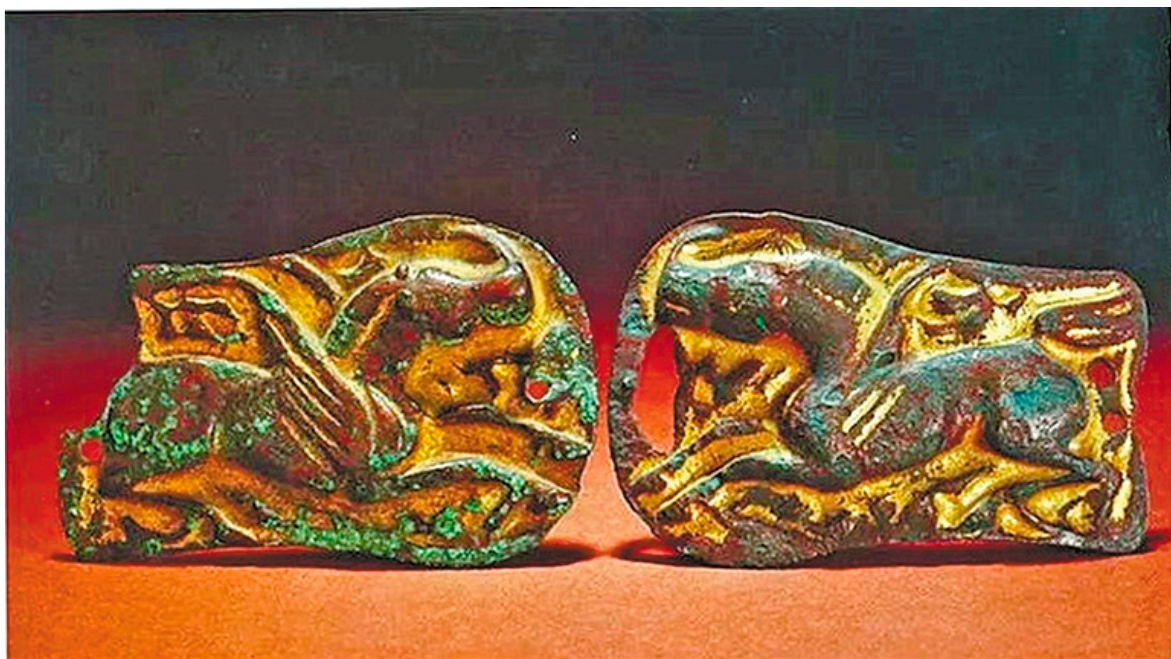
Figure 5. A pair of plaques of galloping horses with wings, bronze, 10 × 6.5 cm, excavated from Jalainur Cemetery, Inner Mongolia. From first to third century CE; after (Zhalainuoer